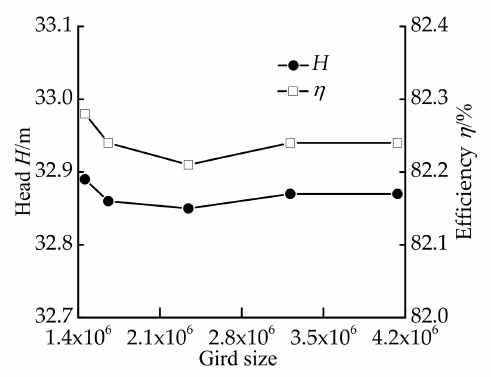
Figure 4. Grid-independence